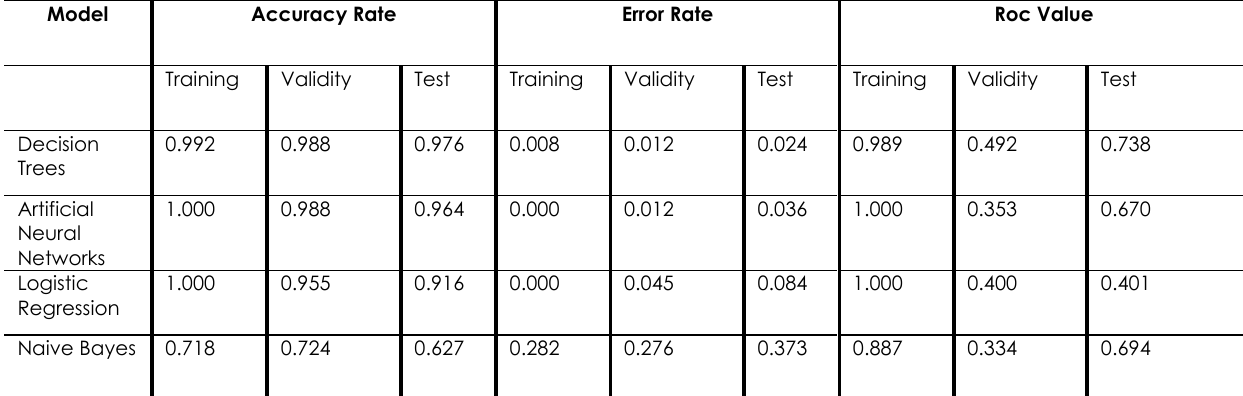
Table 16. Model comparison fit statistics.